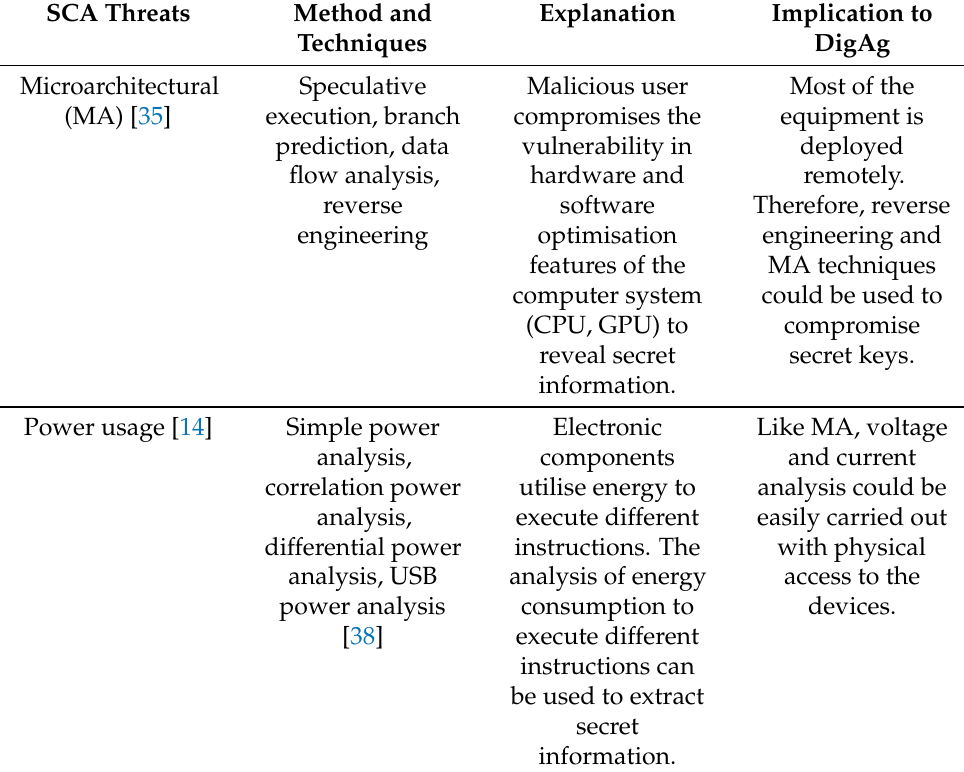
Figure 2. Side-channel attacks for a typical digital agriculture application. Table 2. Side-channel attacks’ classification and implications for digital